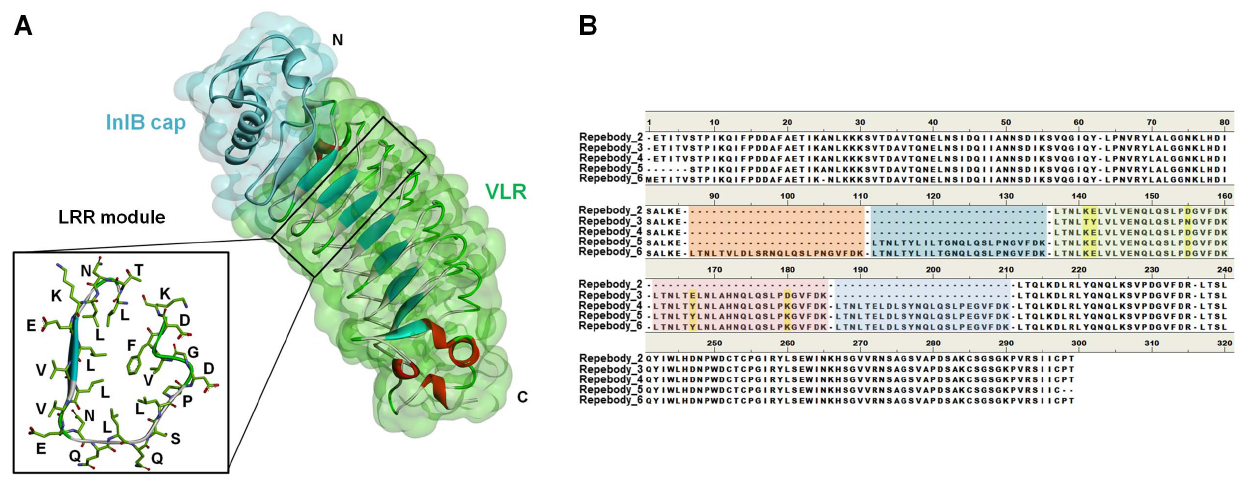
Figure 1. Structure and sequence of repebody. (A) Structural information of repebody which consists of InIB cap (cyan) and VLR (green). LRR module is highlighted in a box and displayed as stick model. (B) Sequence comparison of five different repebodies. The LRR modules are highlighted with different colors; LRR module 1 with orange, 2 with bluish green, 3 with green, 4 with red, with blue. Variable residues are shown as yellow.